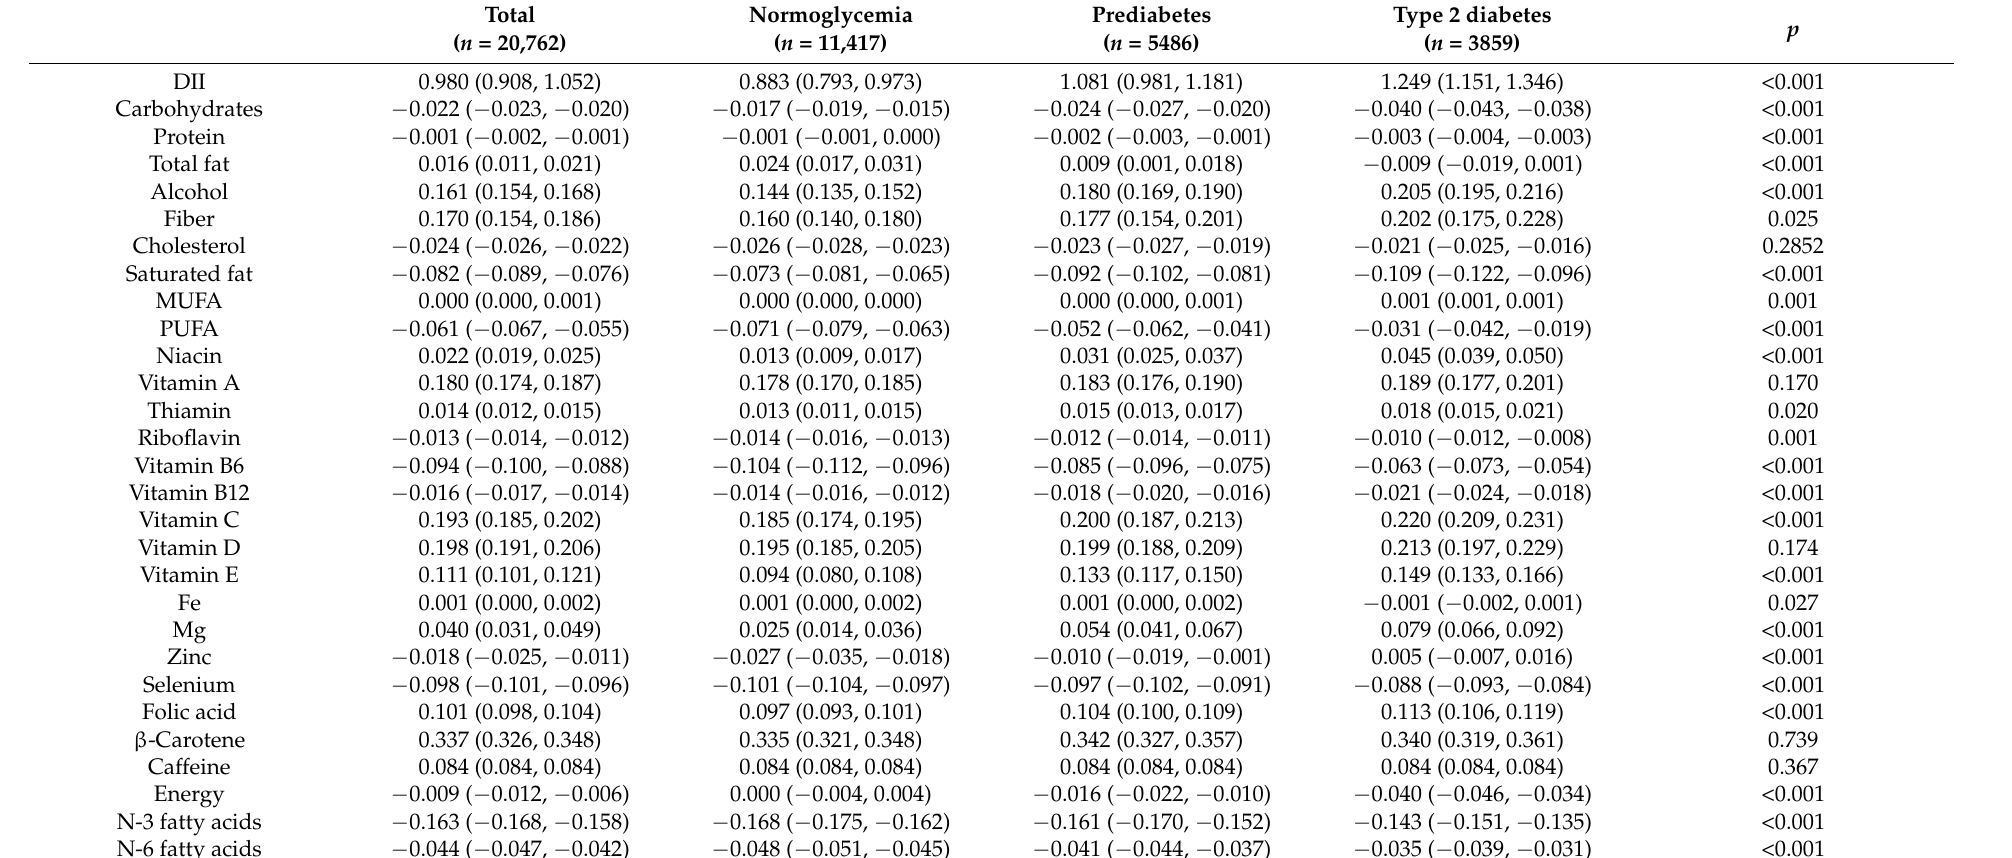
Table 2. Comparison of the components of DII by baseline glycemic